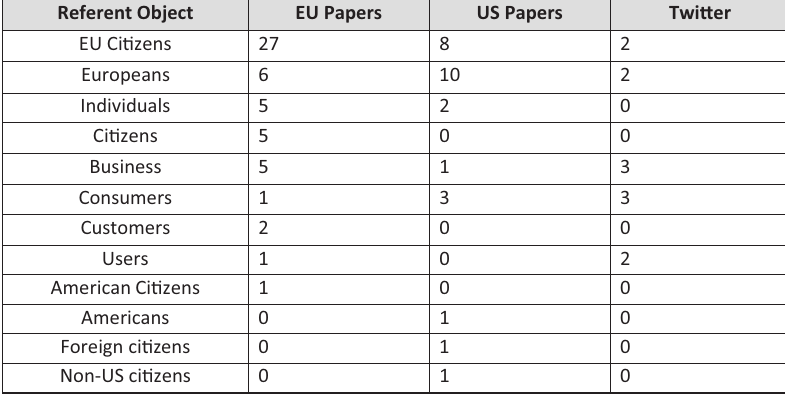
Figure 2: Breakdown of referent object across Newspaper and Twitter